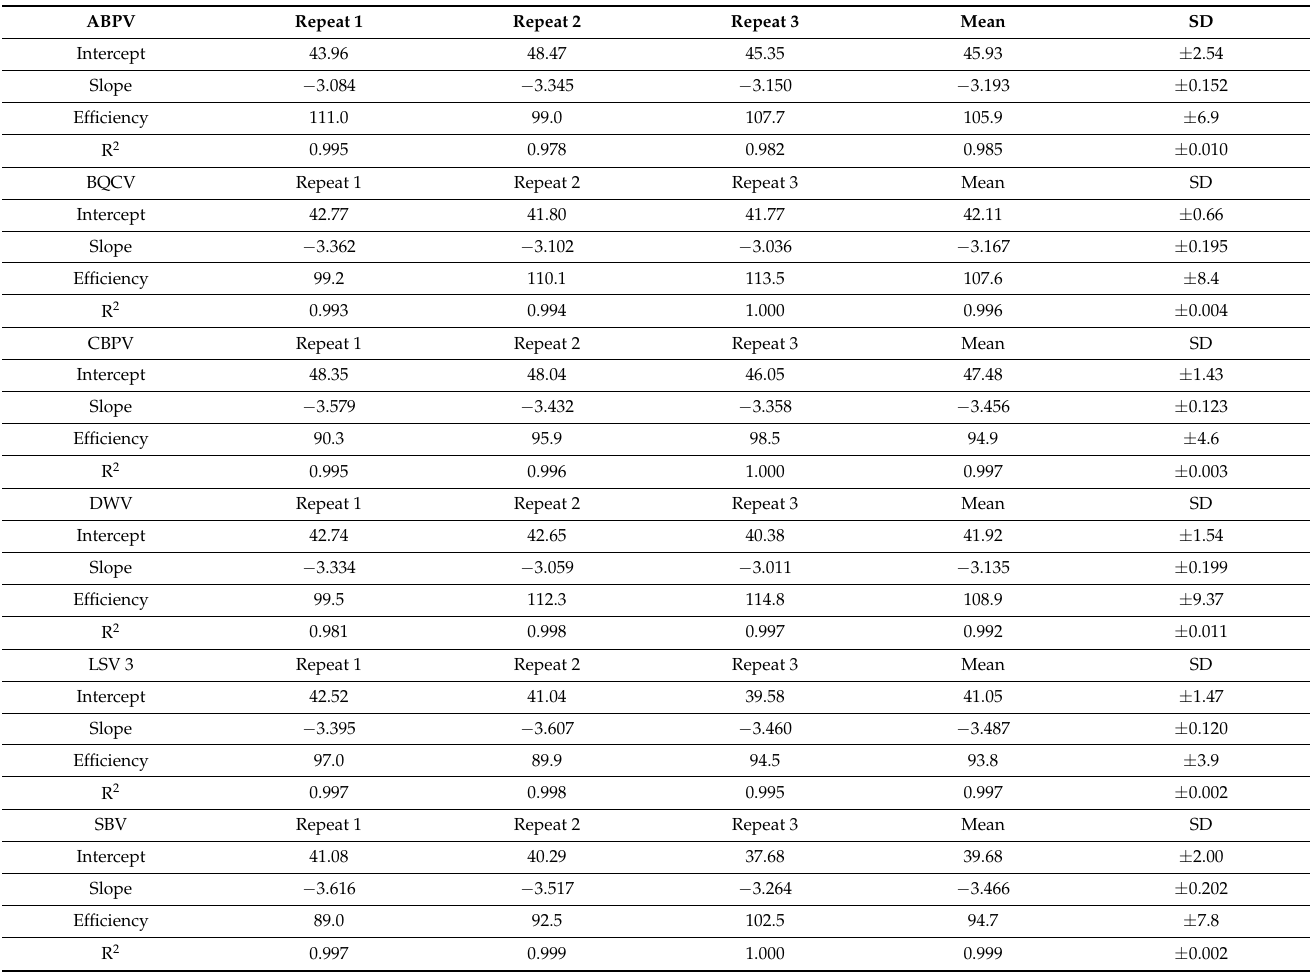
Table 3. The performance of RT-qPCR assays for quantification of ABPV, BQCV, CBPV, DWV, LSV3, and SBV by using 10-fold standard dilutions and three repetitions of each